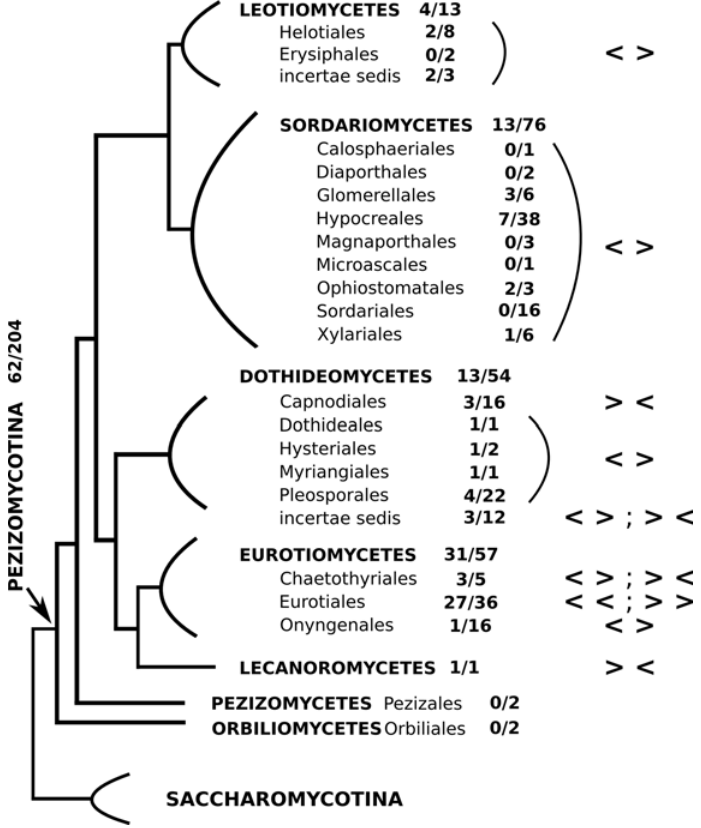
Fig 4. Schematic representation of selective conservation of the CYP630-CPR2 gene cluster in Pezizomycotina. The presence of the gene cluster found in seven Pezizomycotina classes is given as a fraction of the species that the gene cluster was identified in relative to all the species of a given class whose genomes were searched. Homologs of either gene were not identified outside of Pezizomycotina. The relative orientation of both genes is given ( < > — divergent; > < — convergent, << or >> — co-oriented) [47]. The phylogeny was modeled after